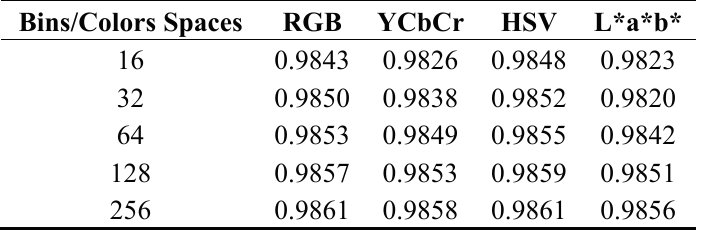
Figure 4. The performance measurement in the four color spaces for histogram resolutions of 64 bins. Table 1. Best accuracy for each color space/quantization